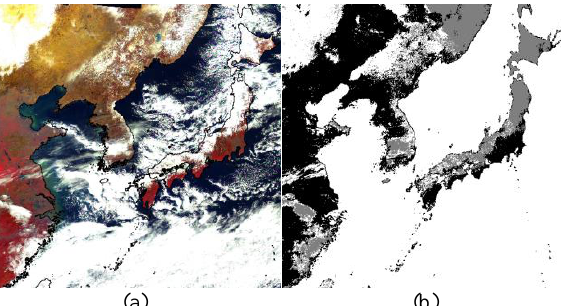
Figure 2. (a) NIR color composite GOCI surface reflectance image and (b) spatial distribution of snow cover detected by the proposed method from GOCI data in Dec 12, 2011 (white: snow cover, grey: clouds, black: clear land surface).